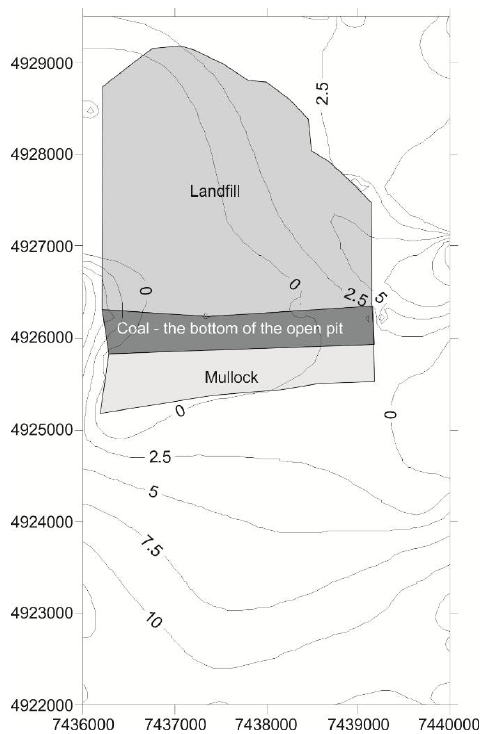
Figure 20. “Residual” groundwater 19 months after the creation of the flood lake at Tamnava–West Field (December 2015).